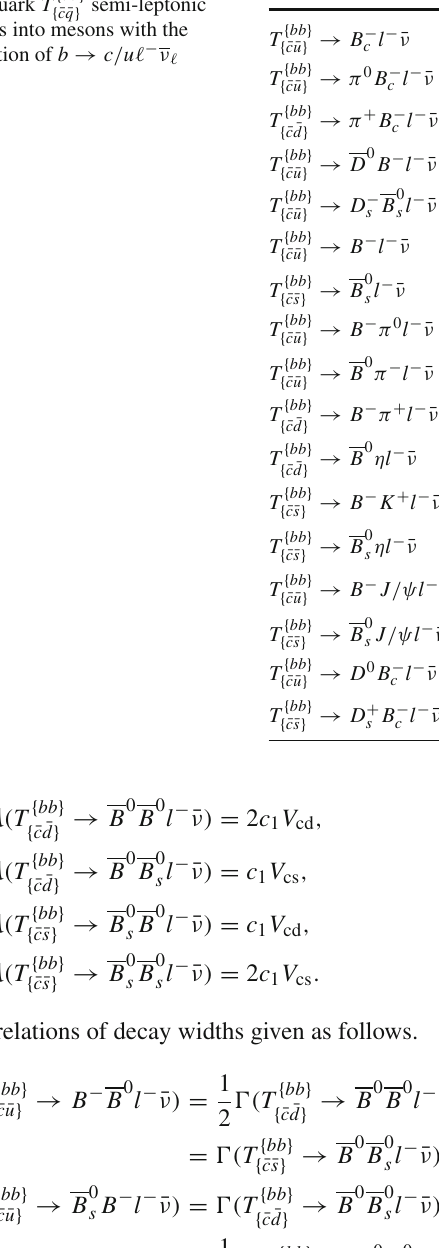
Table 2 Amplitudes for { bb } tetraquark T {¯ c ¯ q } semi-leptonic decays into mesons with the transition of b → c / u (cid:13) − ν (cid:13)